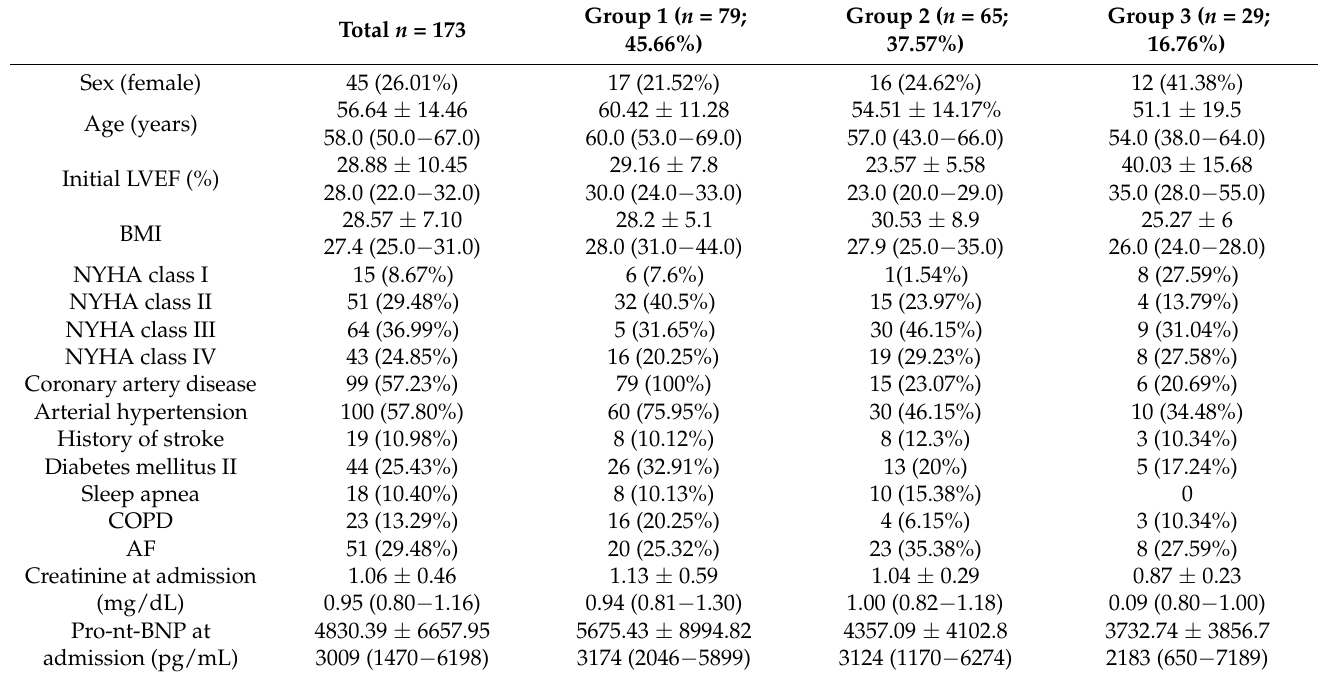
Table 1. Baseline characteristics, described by frequencies ( n , %) or mean and standard deviation (first line) and median and interquartile range (second line).